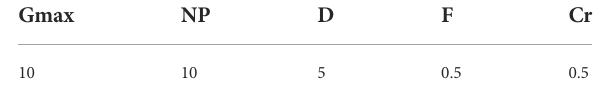
TABLE 4 The parameters of the